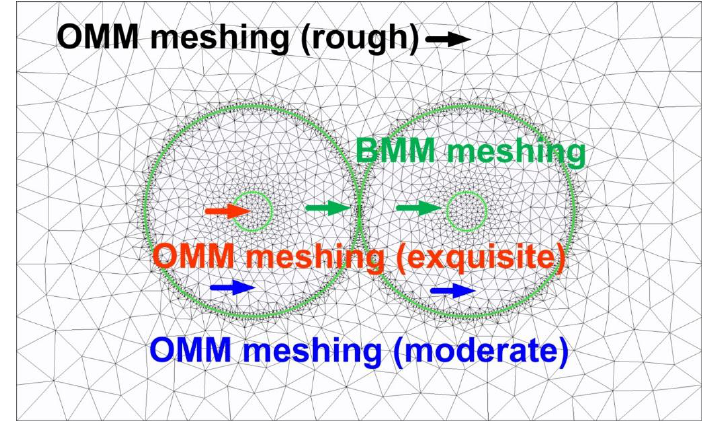
Figure 2. BMM- and OMM-derived meshes for the FBG-OADM simulation.